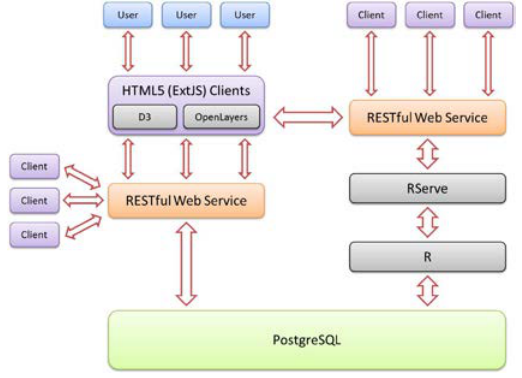
Figure 11. a) Legend for all three pictures, b) completeness percentage by country/year, c) repetition rates by attribute/year, and d) completeness percentage by attribute/year.